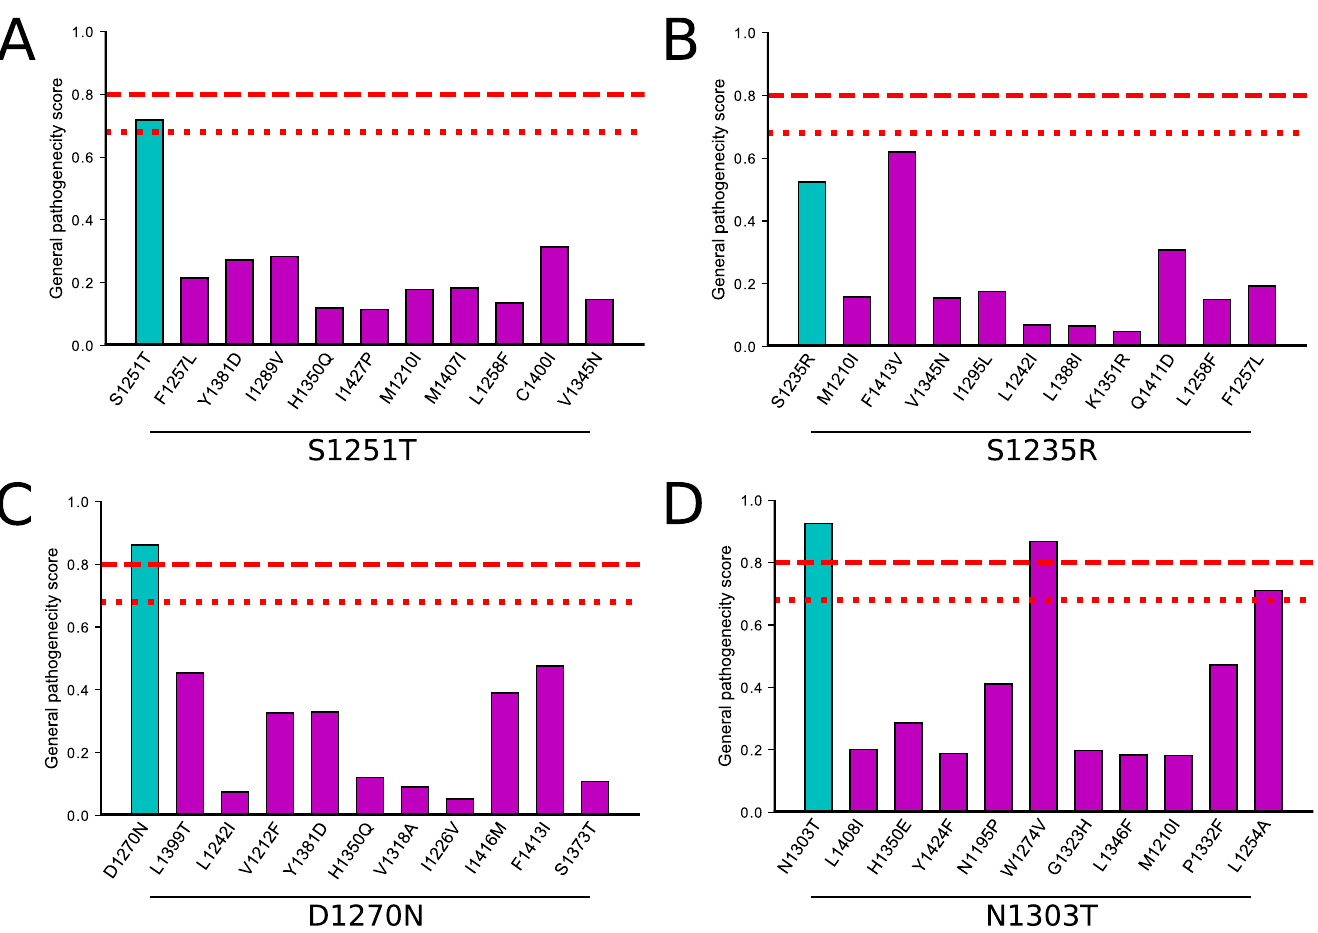
Fig 11. MutPRED analysis of highest ten predicted stabilizing mutations. (A) S1251T perturbation (B) S1235R perturbation (C) D1270N perturbation (D) N1303T perturbation. The general pathogenicity score ranges from zero (benign) to one (pathogenic). A score threshold value of 0.8 for pathogenicity (read dashed line) representing 5% false positive rate, or 0.68 for pathogenicity (read dotted line) representing 10% false positive rate, and P-value threshold of 0.05 was used for analyses.